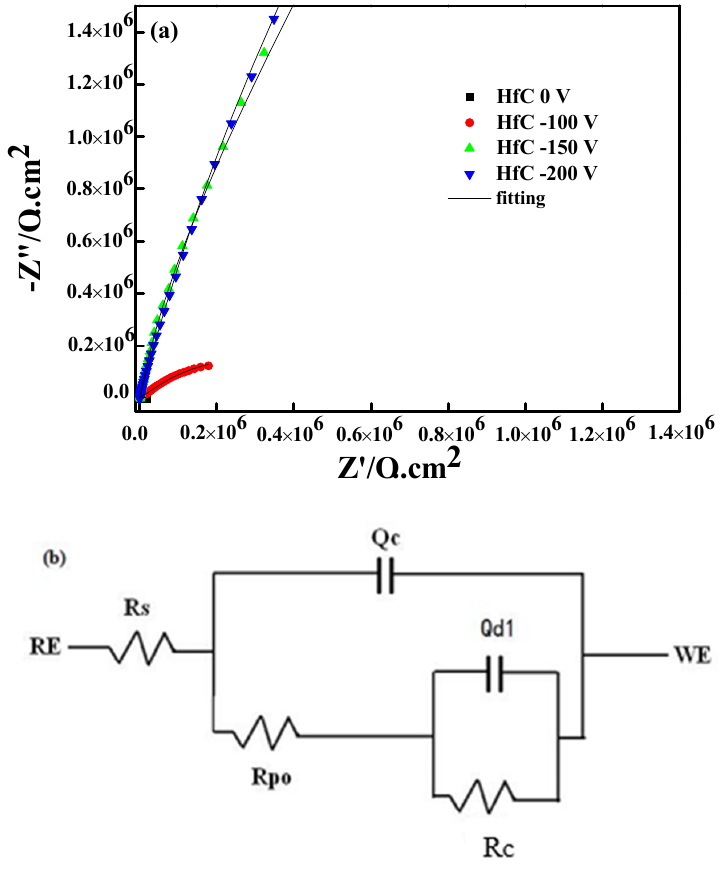
Figure 10. EIS of HfC coatings deposited at different bias voltages. ( a ) Nyquist curve and ( b ) equiva- lent electrical circuit model. Table 2. Corrosion parameters in PBS solution for HfC coatings deposited at different bias volt- ages.